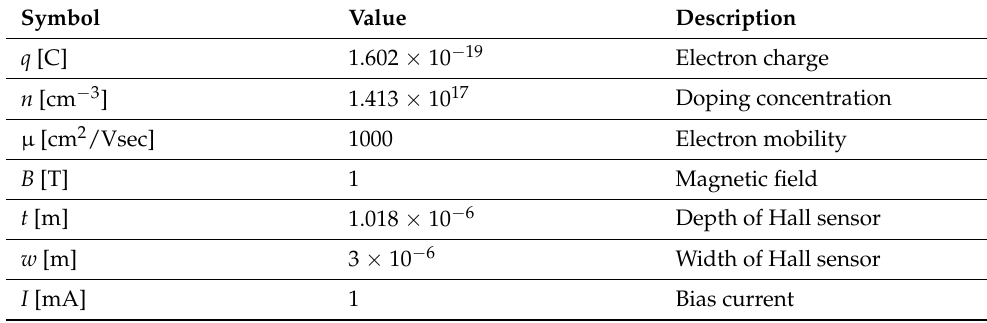
Table 1. Simulation setup parameters.